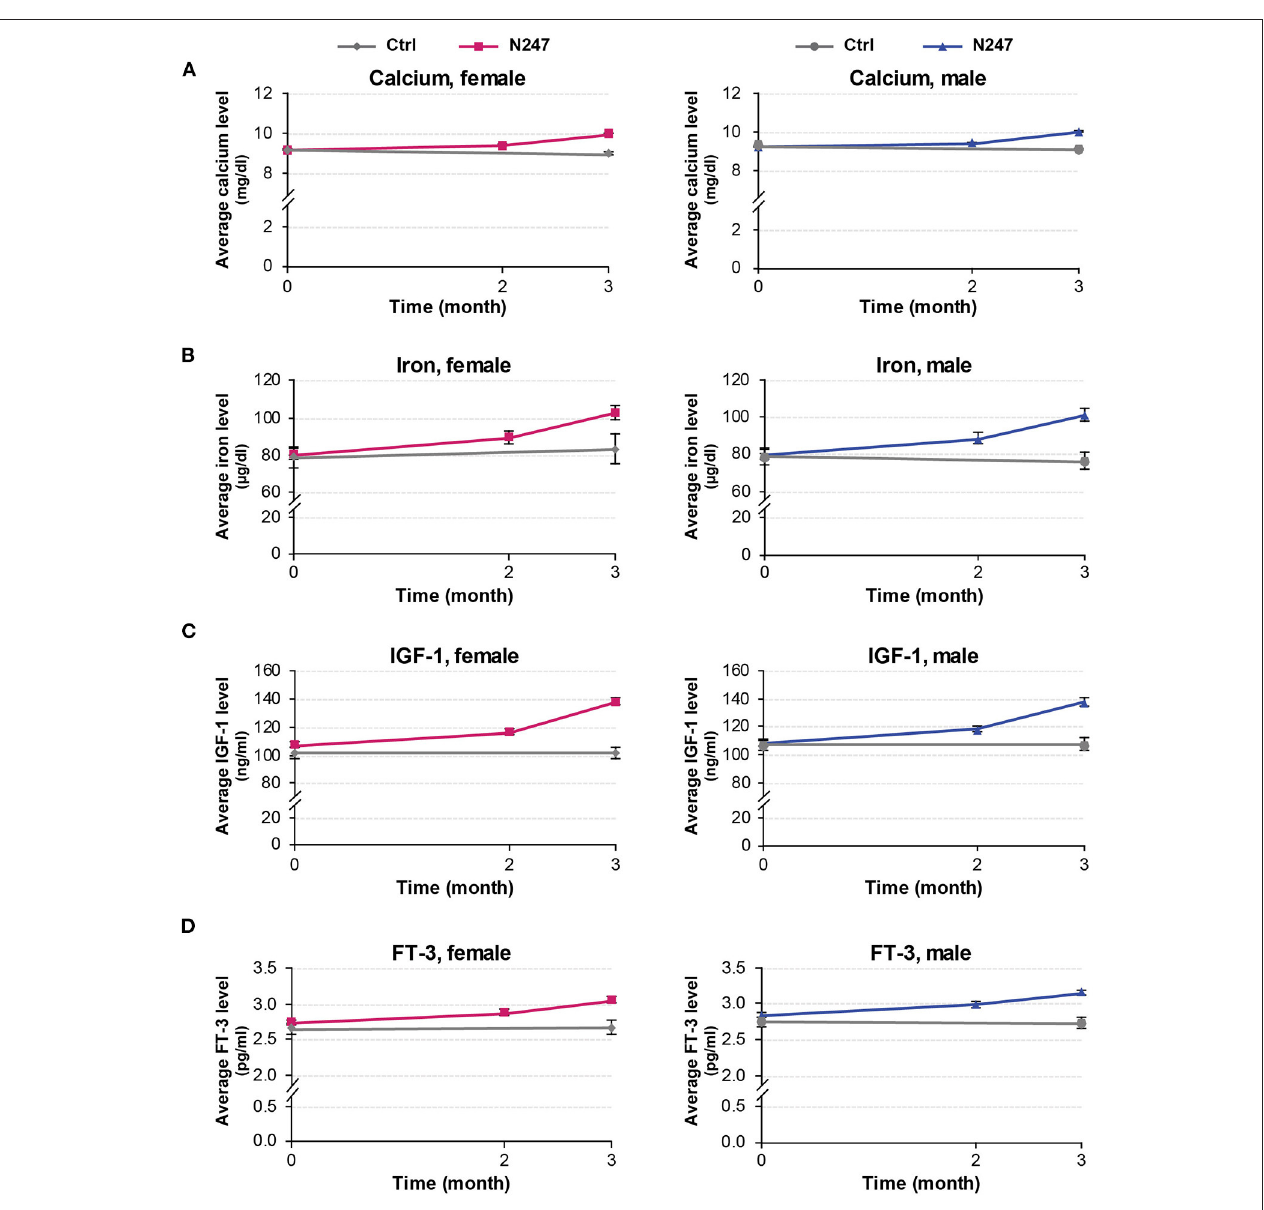
FIGURE 6 | Graphical representation of N247 effects on serum calcium, iron, IGF-1, and FT-3 levels. Serum concentrations of calcium (A) , iron (B) , IGF-1 (C) , and FT-3 (D) in control and N247 receiving group of women and men subjects during the study of 3 months. Values are mean